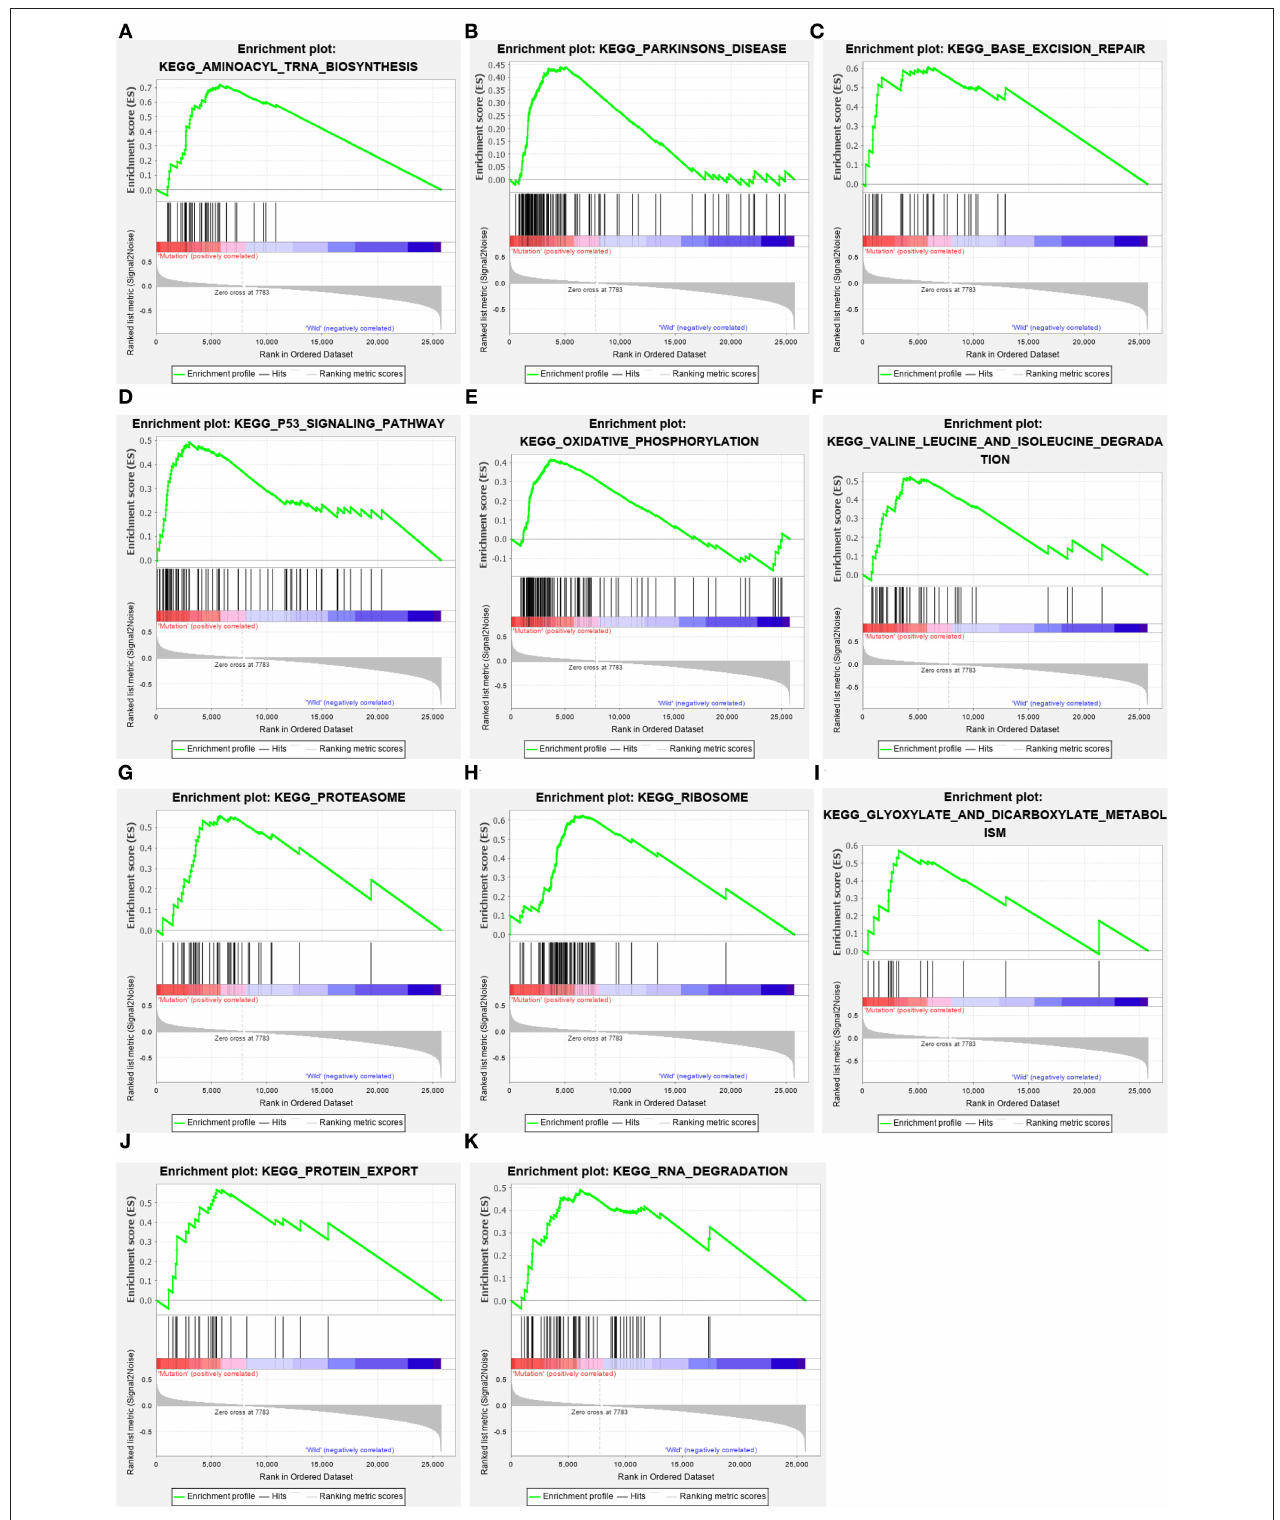
FIGURE 5 | The significantly enriched pathways in mutated PLIN5 GC samples based on GSEA. (A) Aminoacyl-tRNA biosynthesis pathway, (B) Parkinson’s disease pathway, (C) base excision repair pathway, (D) p53 signaling pathway, (E) oxidative phosphorylation pathway, (F) valine leucine and isoleucine degradation pathway, (G) proteasome pathway, (H) ribosome pathway, (I) glyoxylate and dicarboxylate metabolism pathway, (J) protein export pathway, and (K) RNA degradation pathway. GC, gastric cancer; GSEA, Gene Set Enrichment Analysis.